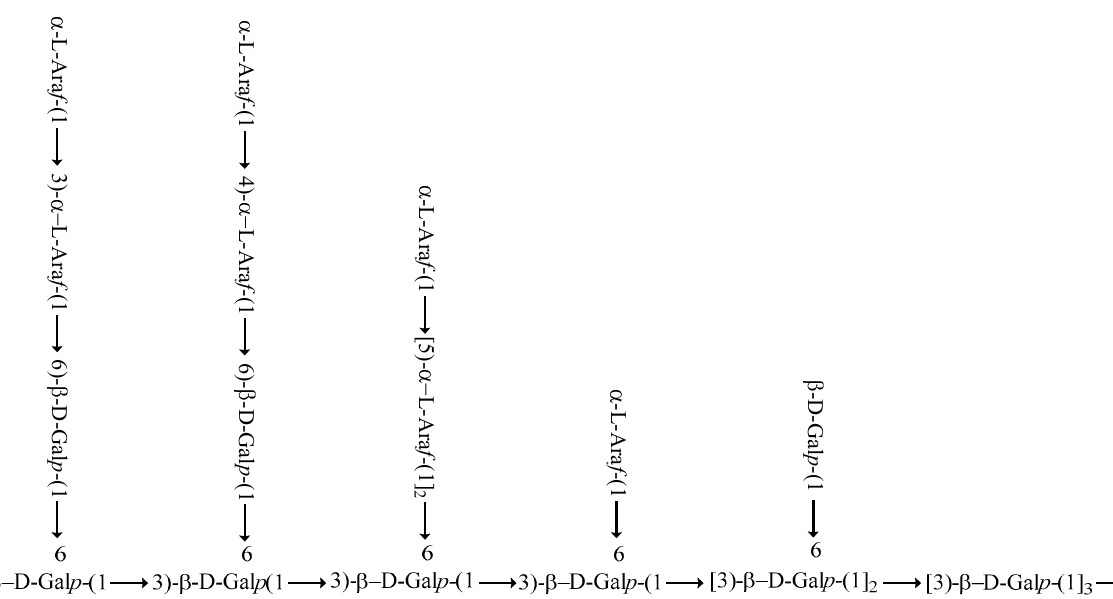
Figure 7. The hypothetical structure of the repeating unit of LRLP—A.